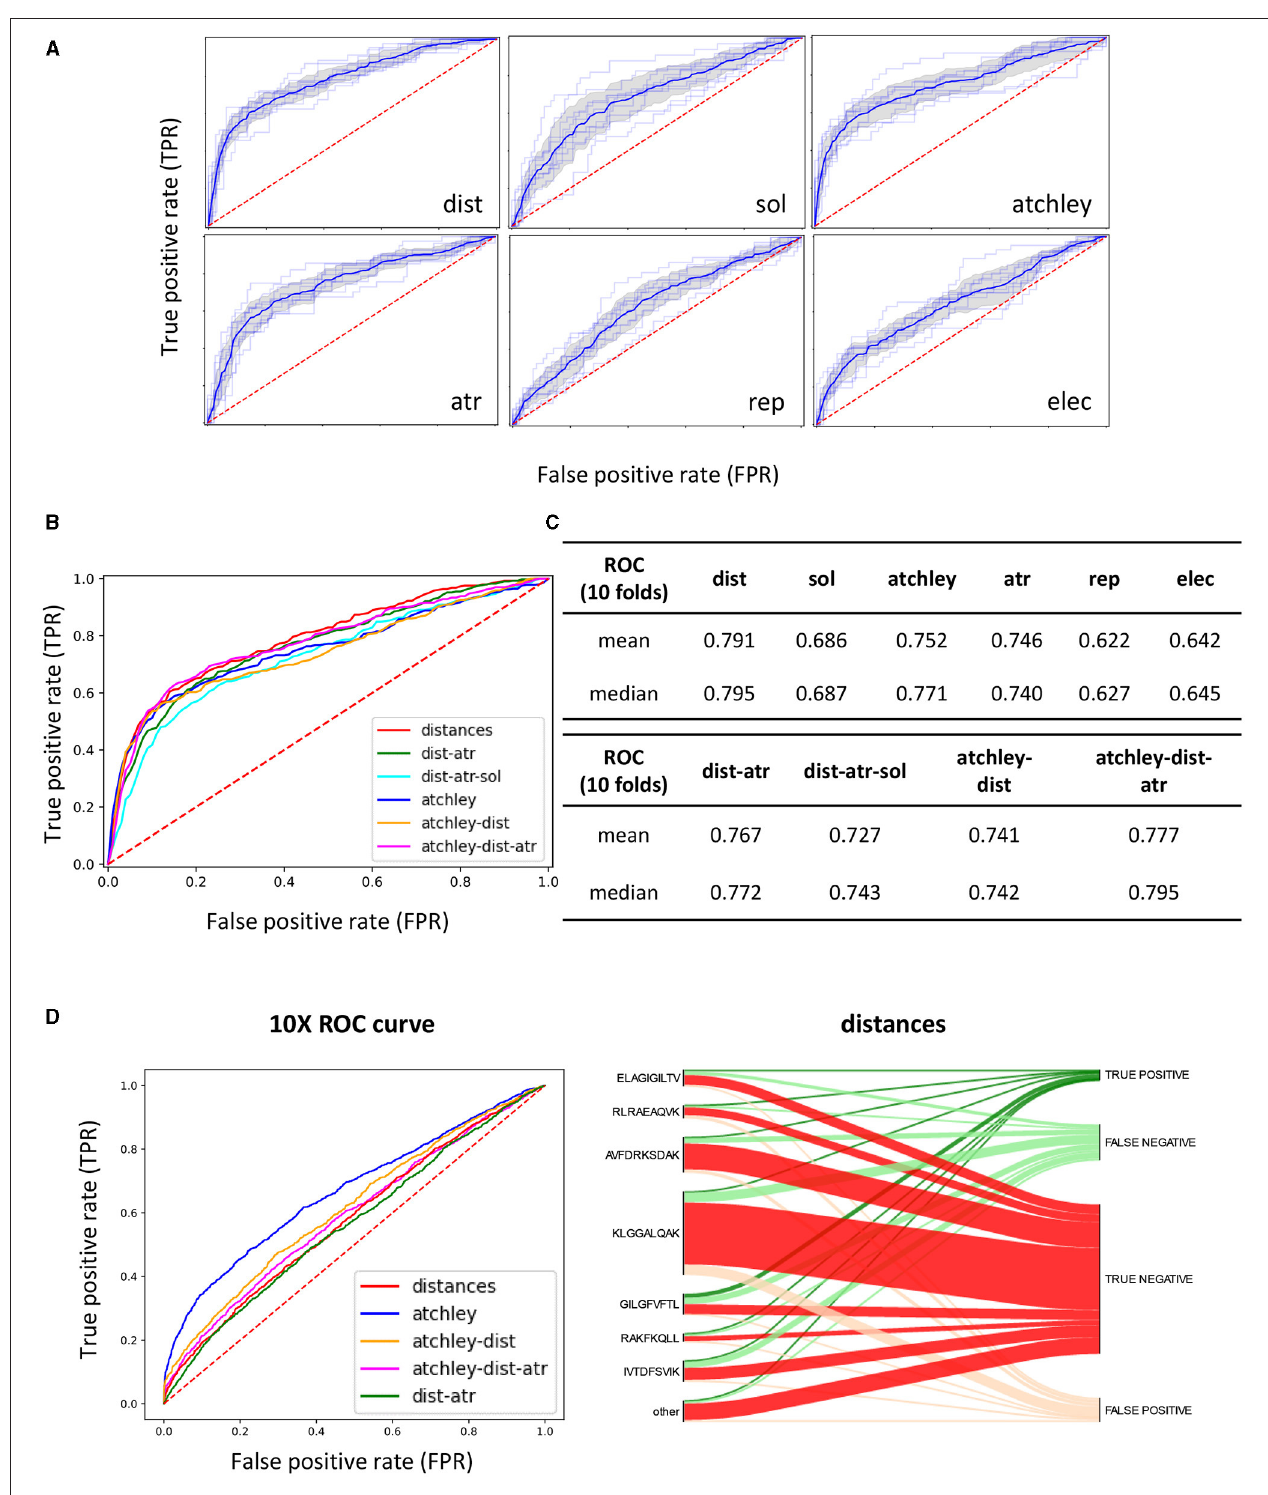
FIGURE 6 | A discriminative classification model can be trained using extracted structural features. (A) ROC AUC curves of 10-fold CV on the STCRDab training set with each feature set separately. The faint lines are the results for each individual fold, whilst the dark lines represent the interpolated average results, with the shaded area as the standard deviation. (B) Interpolated ROC AUC curves for 10-fold CV obtained when combining different feature sets for prediction. (C) Tabular results for